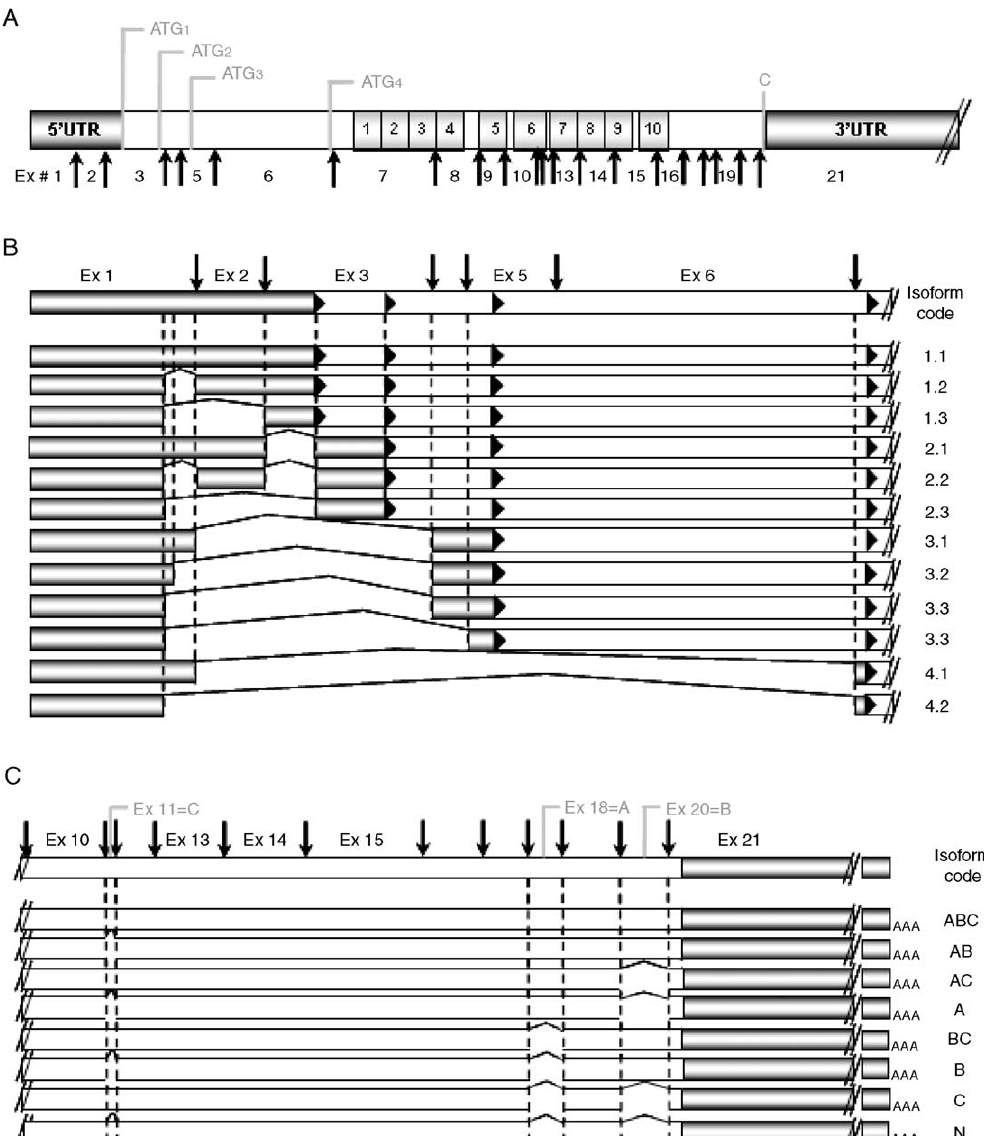
Fig. 1. Schematic diagram of the human p120ctn gene ( CTNND1 ) and from the multiple alternatively spliced isoforms. (A) Structure of CTNND1 gene. ATG 1 − 4 represent the positions of the four alternatively used start codons; C is the position of the stop codon; numbered boxes (1 to 10) correspond to the encoding sequences of Armadillo repeats; exons are indicated by numbers (1 to 21), separated by vertical arrows. (B) Schematic representation of the various isoforms generated by alternative splicing in 5’ region of CTNND1 gene. Vertical arrows separate each exon, and triangles represent the four different start codons that can be alternatively used. The codes for the encoded protein isoforms are shown on the right. (C) Schematic representation of the alternatively used exons in 3’ region of CTNND1 gene. Exons are separated by vertical arrows, triangle corresponds to the stop codon and a poly(A) addition site is also represented (AAA). The codes for the encoded protein isoforms are shown on the right (adapted from